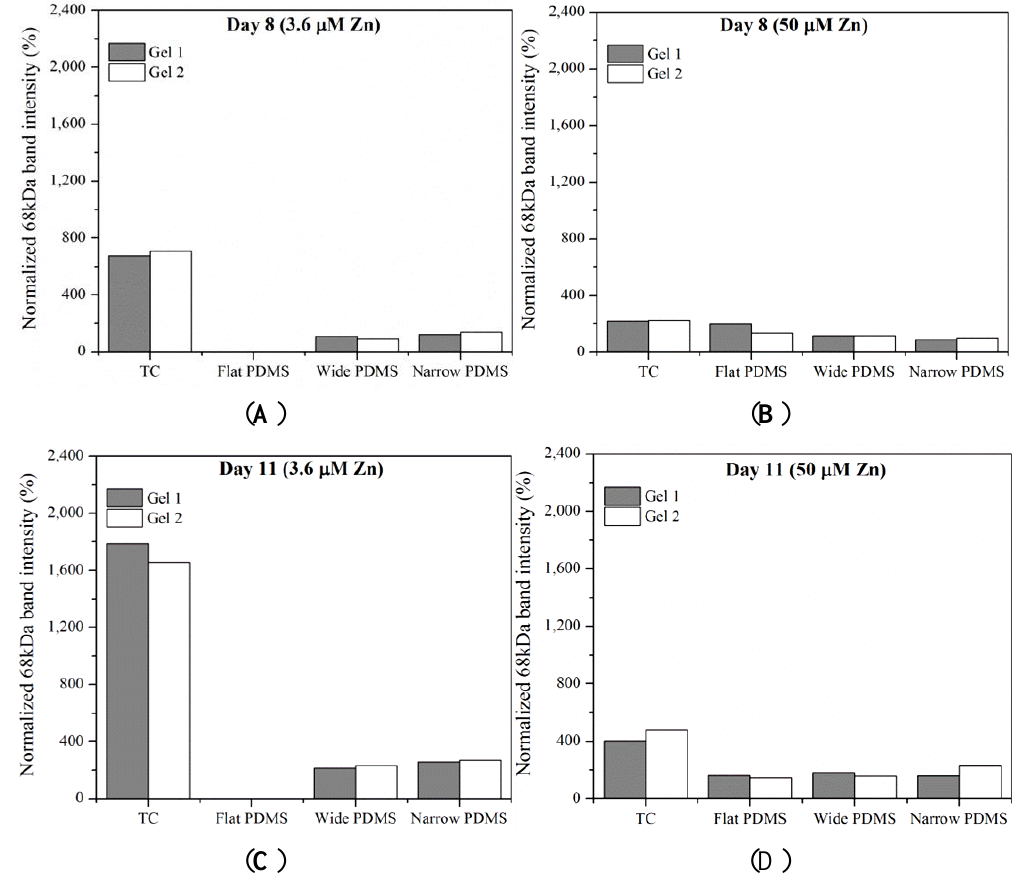
Figure 2. Intensity of 68 kDa gel zymogram bands (normalized to the 72 kDa bands of each corresponding gel) from extracts of MC3T3-E1 cells collected on day 8 in ( A ) 3.6 µM Zn and ( B ) 50 µM Zn, and on day 11 in ( C ) 3.6 µM Zn and ( D ) 50 µM Zn. Data represent band intensities from two independent gel zymography experiments. Intensity values were not reported for extracts from flat PDMS samples at 3.6 µM zinc because the bands were too